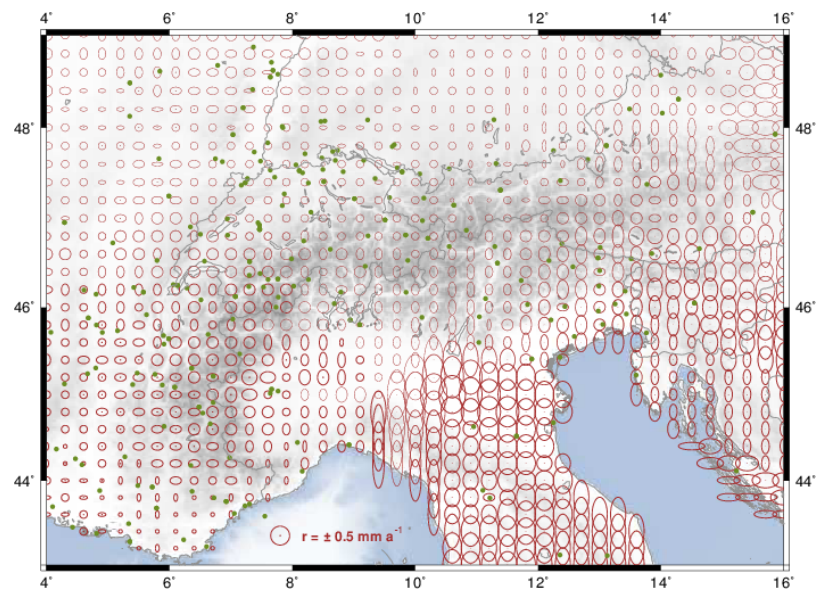
Figure 10. Estimated uncertainty (95% confidence) of the GNSS-based horizontal deformation model of the Alpine region. Green dots show the CO-GNSS station distribution. Topography and bathymetry after the ETOPO1 model (Amante and Eakins,